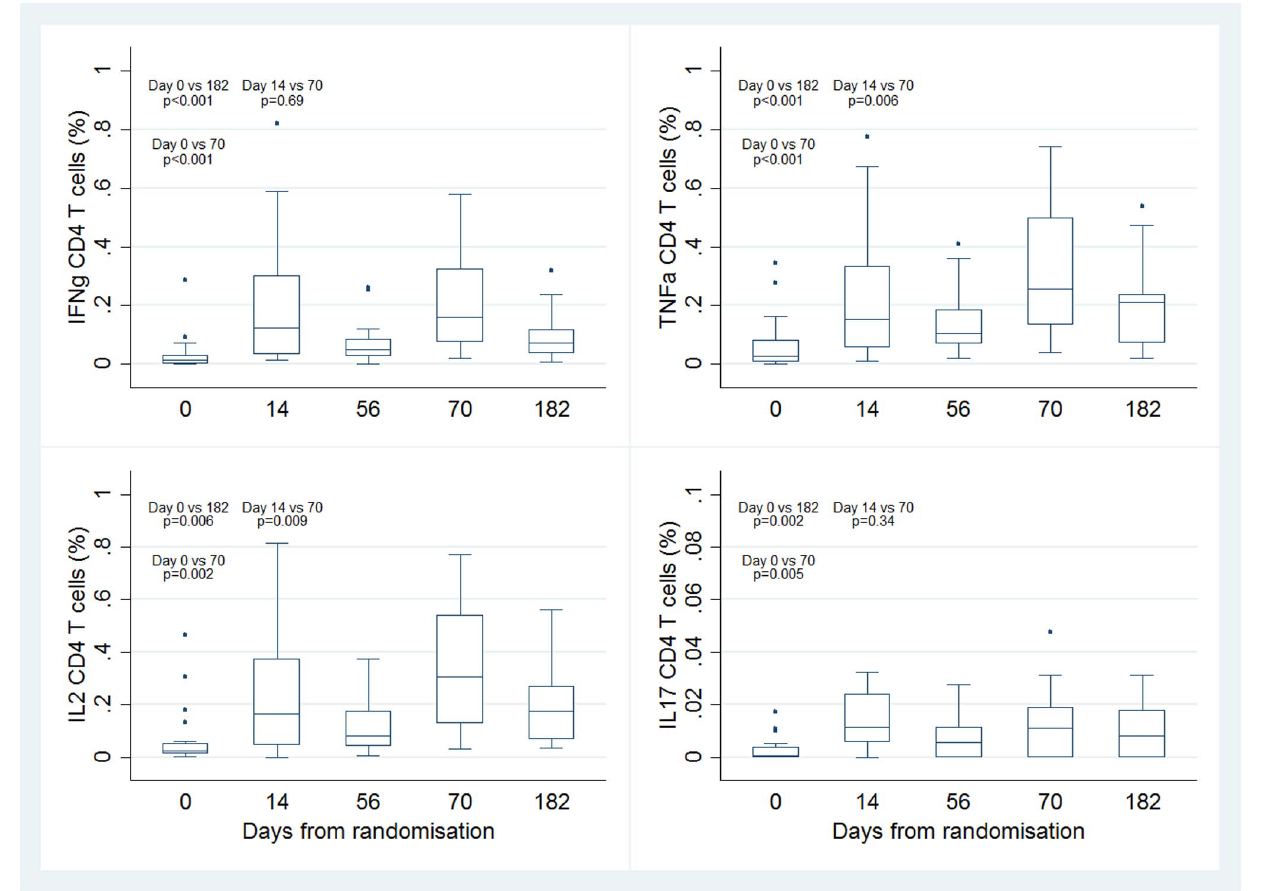
Fig. 4. Kinetics of IFN- c , TNF- a , IL-2 and IL-17 expressing CD4 + T cells after stimulation with H1 over a 6-month period (day 0–182) in the H1/IC31 vaccination group detected by a short-term whole blood intracellular cytokine assay. Footnote: sample size for all measurements at days 0, 14 and 56 was n 5 20 and for day 70 and 182 was n 5